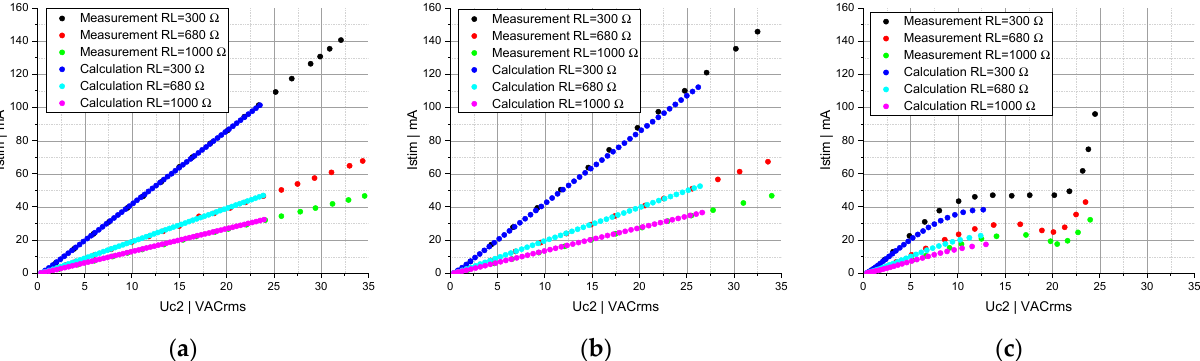
Figure 9. Stimulation current Istim as a function of the induced voltage Uc2 for a circuit topology of two parallel-connected capacitors consisting of: ( a ) two linear capacitors; ( b ) a linear and a nonlinear capacitor; ( c ) two nonlinear capacitors. The measurements (black, red, green) and calculations (blue, cyan, magenta) were performed for R L = 300 Ω , 680 Ω and 1000 Ω , respectively.